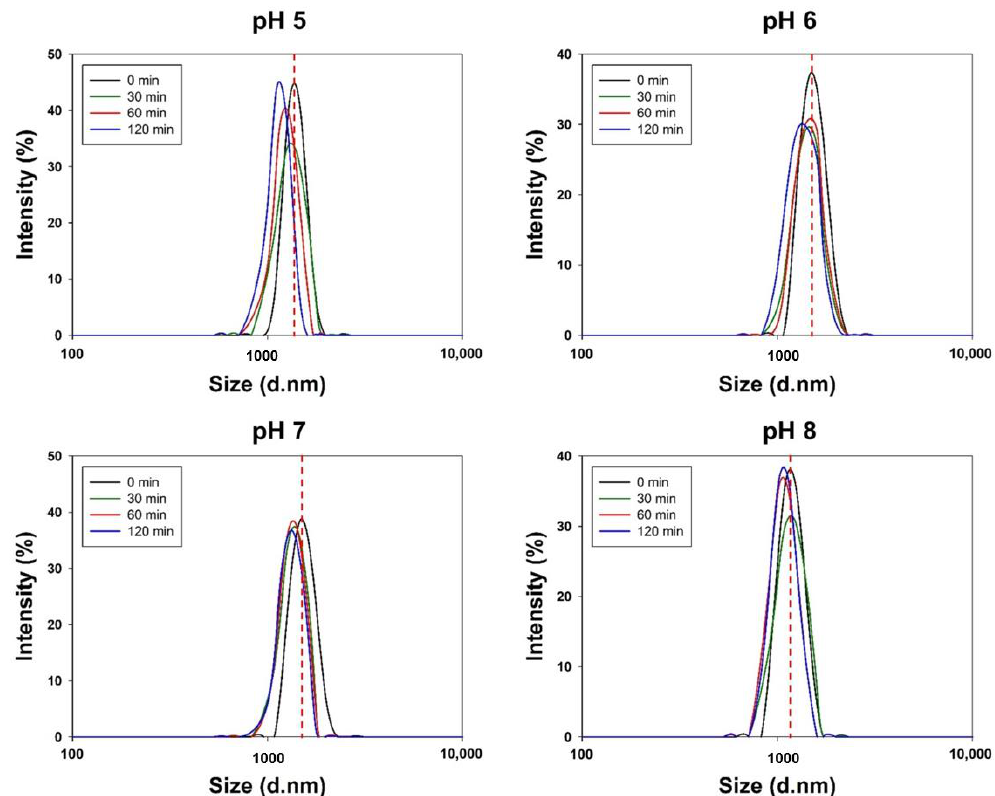
Figure 3. Size distribution of Cur-PLGA-DPPs at different pH values.